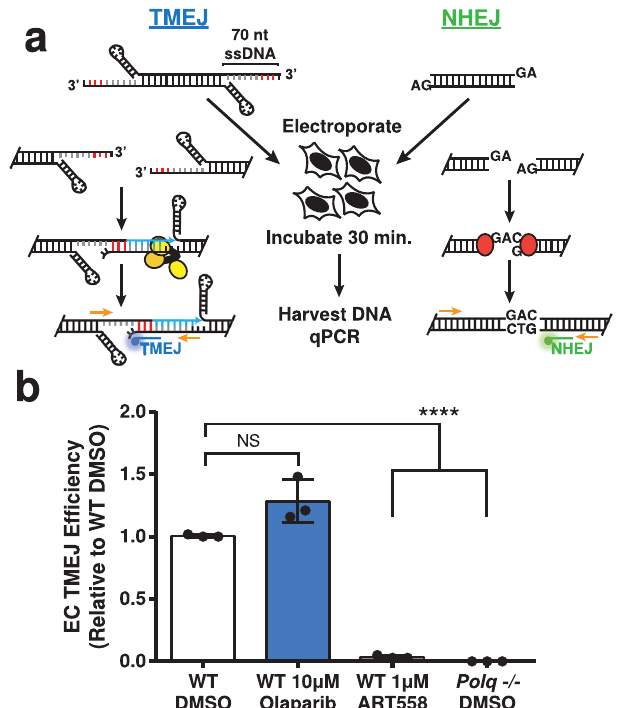
Fig. 1 | PARPi does not impact extrachromosomal TMEJ. a Schematic of the extrachromosomal assay (EC) and pathway-speci fi c probe qPCR (orange primers withblueTMEJandgreenNHEJprobes).ThemicrohomologyintheTMEJsubstrate is shown in red and Polq-dependent synthesis in blue. The helicase-like and poly- merase domains of Pol θ are shown as yellow ovals, and Ku is shown as red ovals. b TMEJ substrate joining ef fi ciency, normalized with NHEJ substrate joining ef fi - ciency to account for differences in transfection ef fi ciency, is expressed as a frac- tionof the TMEJ observed inwild-type MEFstreated withvehicle (WTDMSO).Data shown are mean±standard deviation (SD) ( n =3). Statistical signi fi cance of differ- ences, relative to WT DMSO cells, was determined by one-way ANOVA (**** p <0.0001; NS, p =0.87, not signi fi